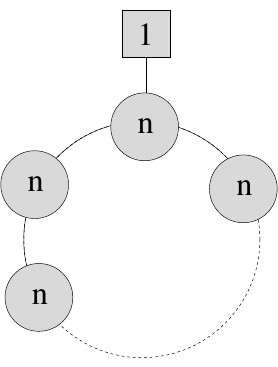
Figure 2 . The quiver for U( N )